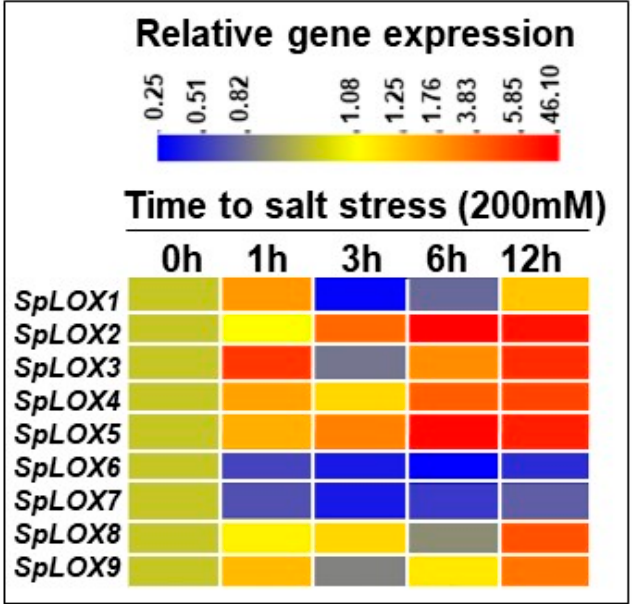
Figure 8. Comparative qRT-PCR analysis of LOX genes in Spirodela in response to exogenous salt. Five fronds of S. polyrhiza 7498 were grown for 14 days; then 200 mM NaCl solution was added; and samples were harvested at 0, 1, 3, 6, and 12 h [36]. Gene expression data were analyzed by qRT-PCR. The experiment was repeated three times ( n = 3) with each sample size of approximately 100 fronds. Analysis of variance (ANOVA) with Dunnett’s multiple comparisons test was performed for significant differences. Statistical significance between data points was assessed against 0 h versus other time points of expression profiles using graph pad (version 8.0).